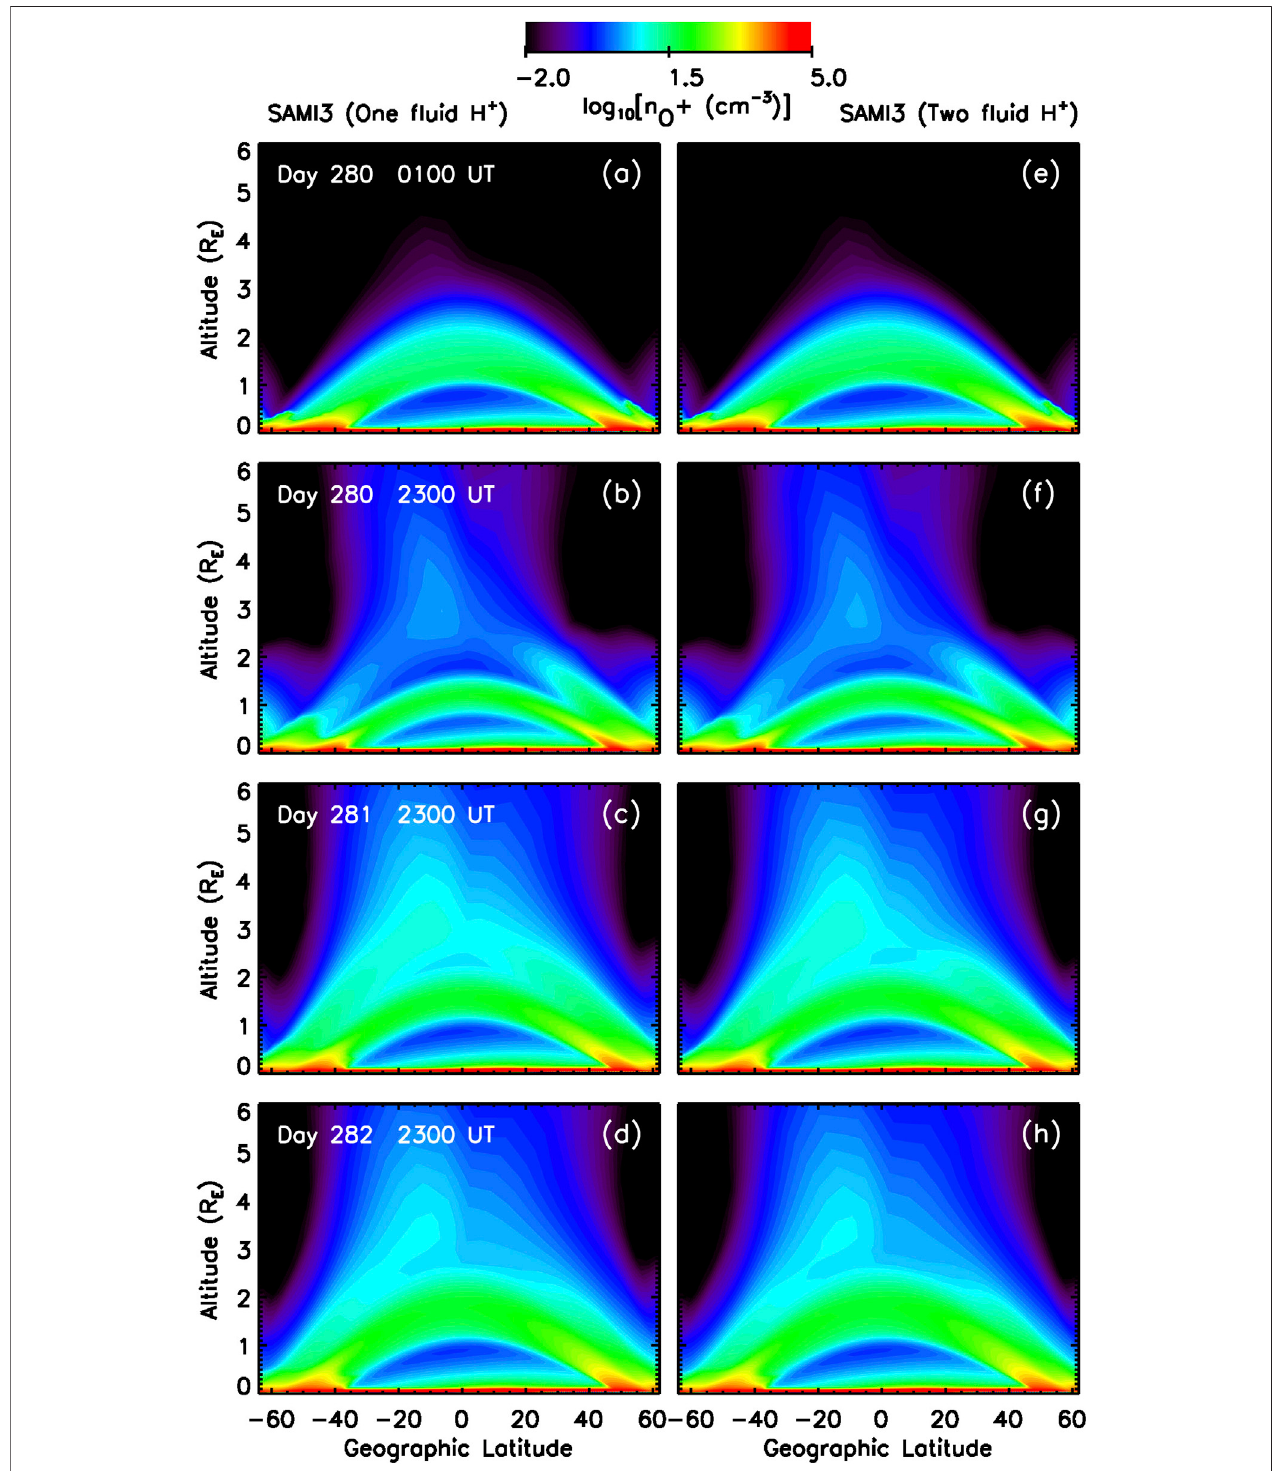
FIGURE4| ColorcontoursofthelogoftheO + densityareshownatthesametimesasin Panel2 forSAMI3 (leftcolumn) andtwo-streamSAMI3 (rightcolumn) . While the density peak at high altitude implies that O + is also affected by the colliding- fl uid issue, analysis shows that this is not the case.